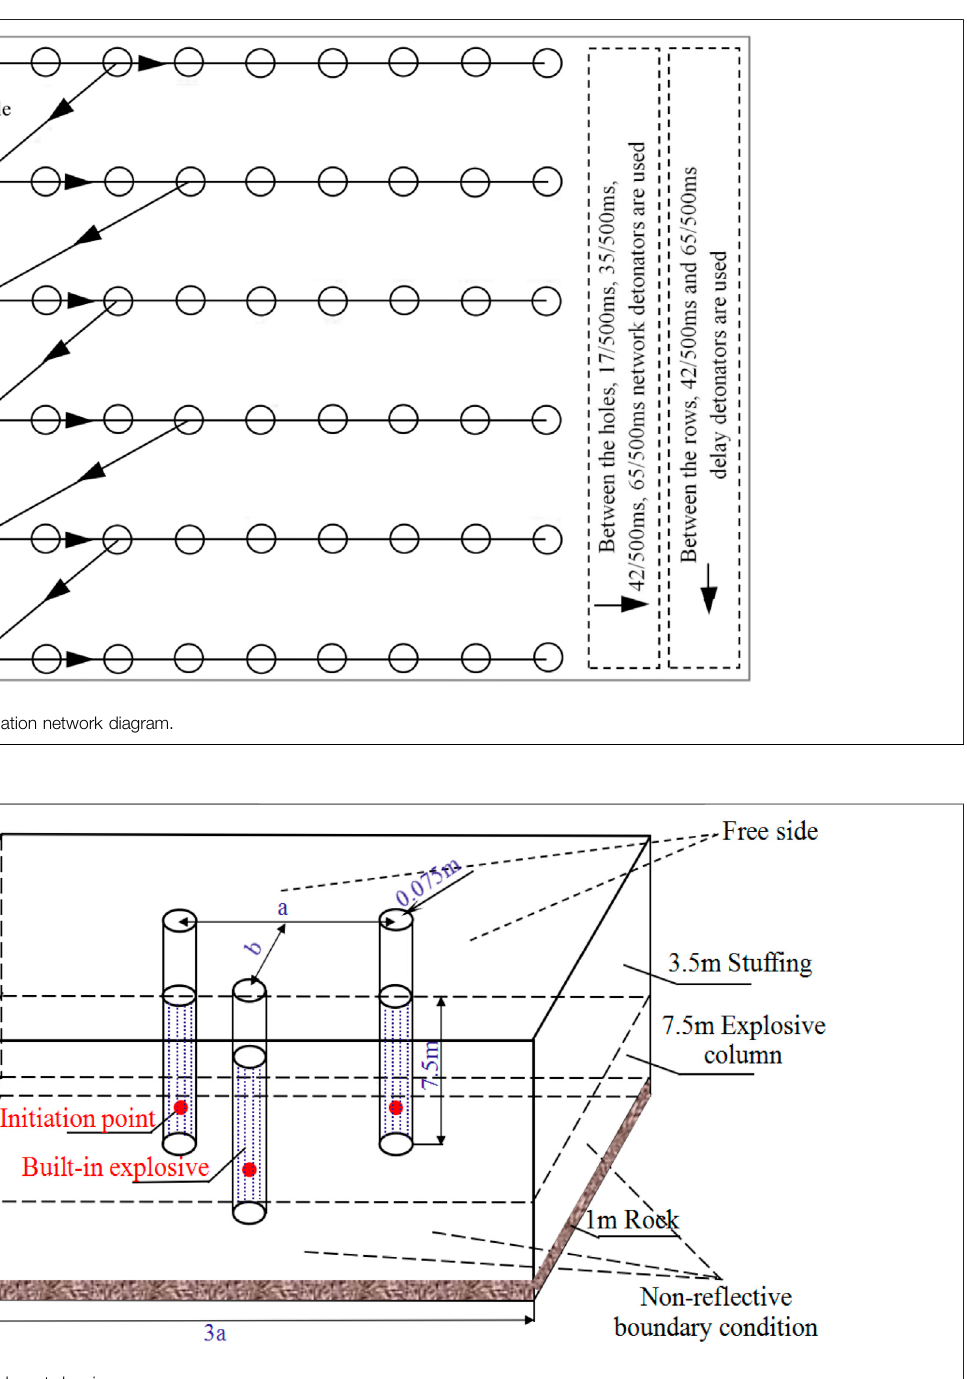
FIGURE 3 | Model size and blasthole layout